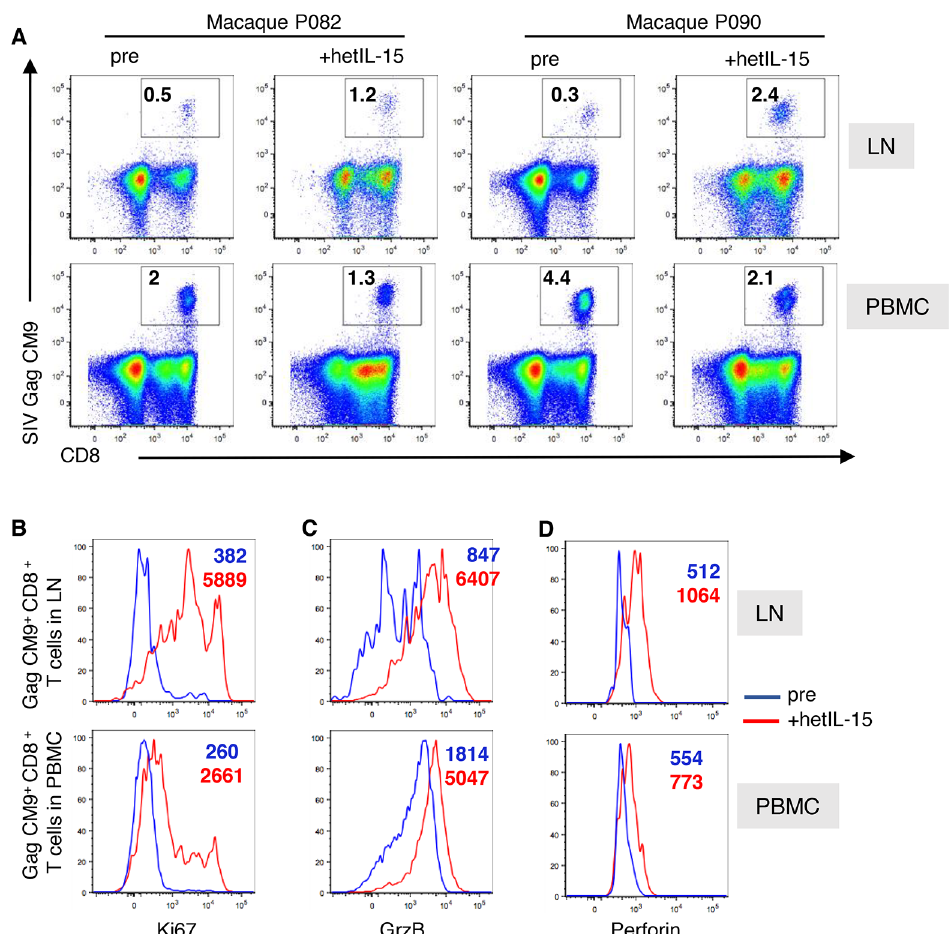
Fig 5. Effects of hetIL-15 on SIV-specific CD8 + T cells in peripheral blood and LN of two gag DNA vaccinated MamuA (cid:3) 01 + macaques. (A) Dot plots showing changes in the frequency of Gag CM9-specific CD8 + T cells in axillary LN and PBMC upon hetIL-15 treatment of macaques P082 and P090. These animals received a SIV gag DNA vaccine. The CM9-tetramer responses are expressed as % of total T cells. For staining, the PE-conjugated CM9 tetramer (MBL International Corporation) was added to the samples 5 min prior to the addition of the antibody cocktail for surface staining. (B, C, D) Histogram overlays show increased levels of Ki67 (B), GrzB (C) and perforin (D) in Gag CM9- specific T cells upon hetIL-15 treatment in LN and PBMC. pre, blue line, +hetIL-15, red line. Numbers within the histogram overlays show the mean fluorescent intensity (MFI) for the specific markers.